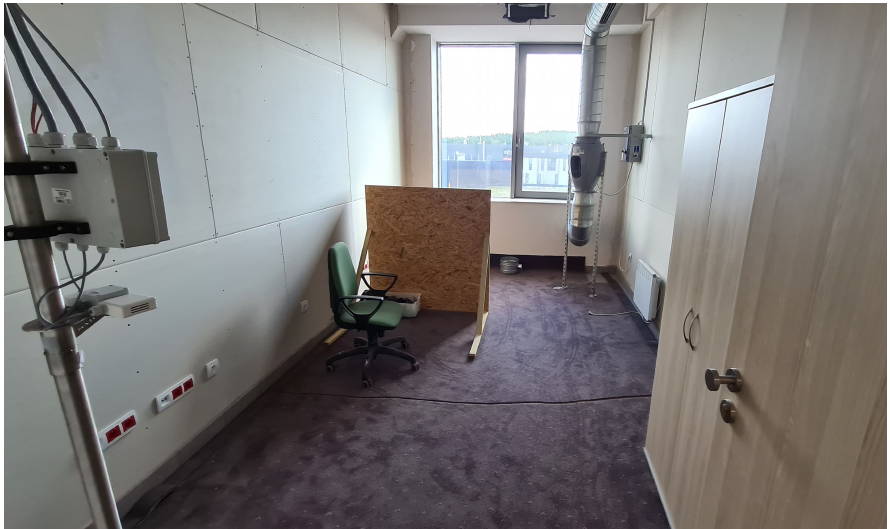
Figure 3. Room L (light construction); view of the room with location of ventilation and measure- ment